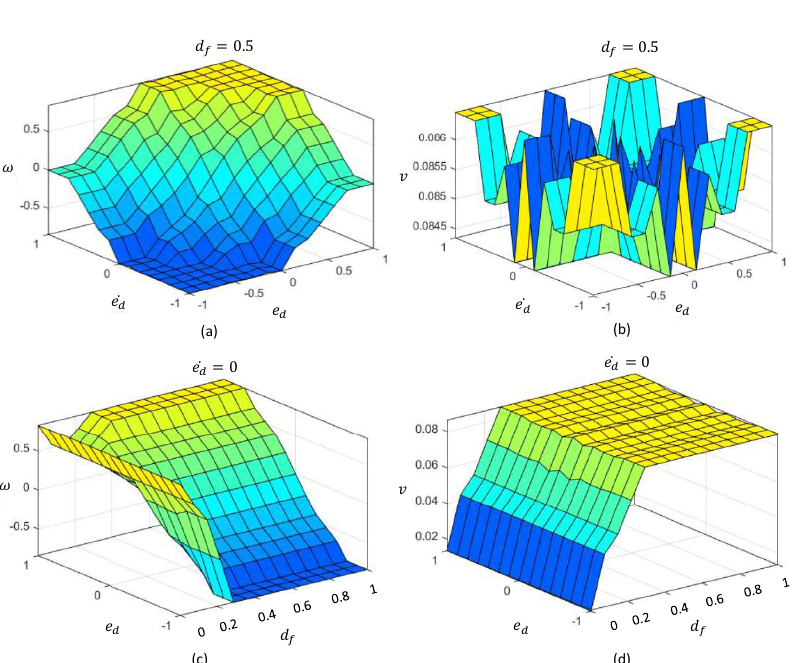
Figure 7. Decision surfaces of the IT2-FLS. ( a ) Variation of w with e d and ˙ e d , when d f = 0.5. ( b ) Variation of v with e d and ˙ e d , when d f = 0.5. ( c ) Variation of w with e d and d f , when ˙ e d = 0. ( d ) Variation of v with e d and d f , when ˙ e d =